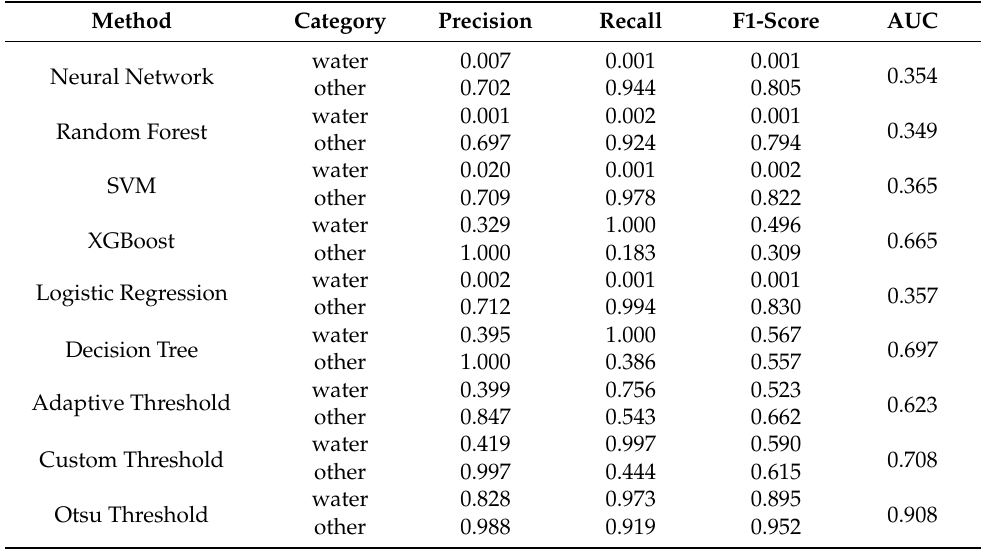
Table A8. Statistics of various indexes of each algorithm in Area3 on October